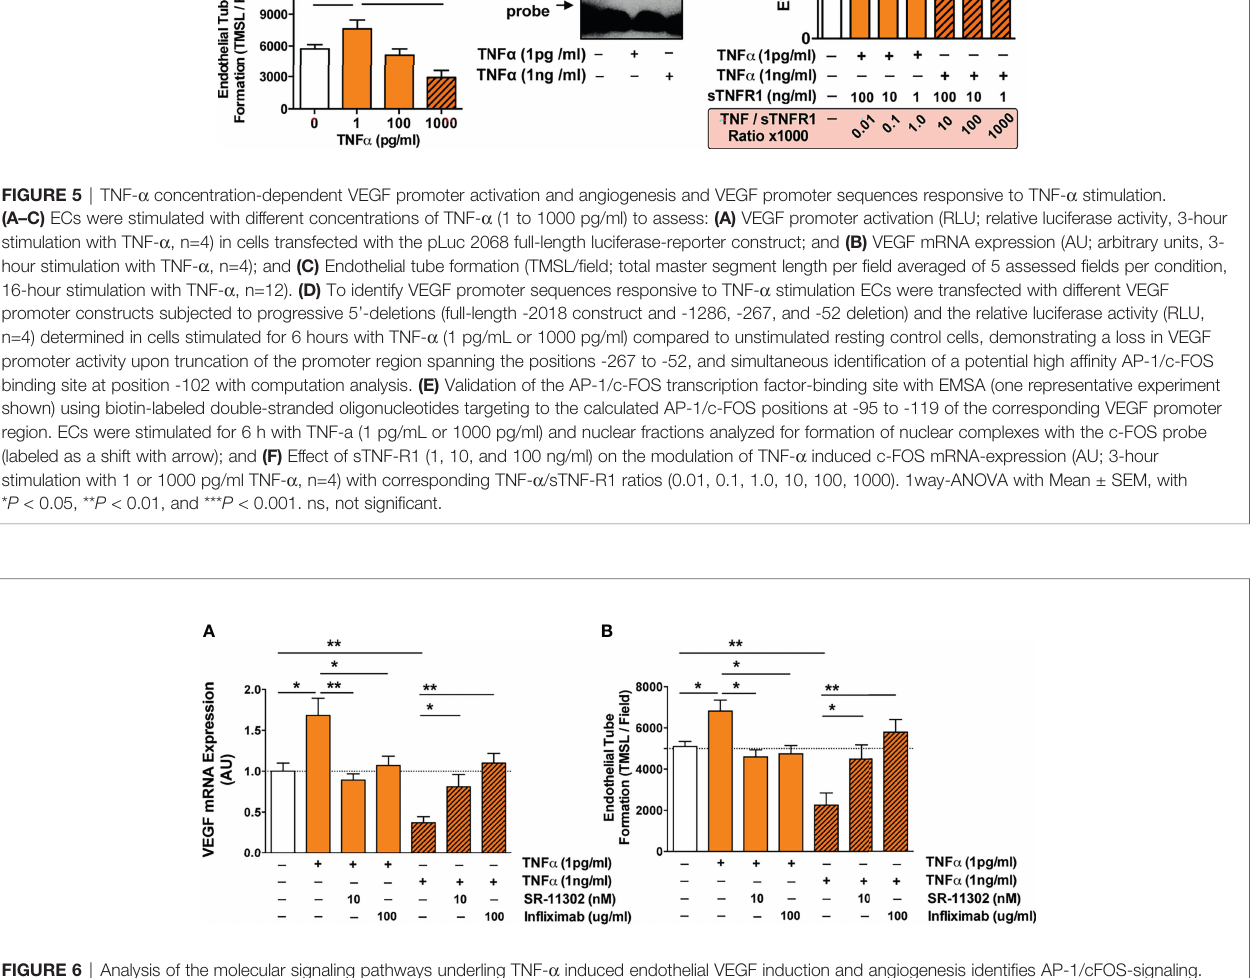
FIGURE 6 | Analysis of the molecular signaling pathways underling TNF- a induced endothelial VEGF induction and angiogenesis identi fi es AP-1/cFOS-signaling. (A, B) Role of the AP-1/c-FOS signaling pathway in low and high TNF- a level-induced endothelial VEGF induction (AU; n=5) shown in (A) and in vitro angiogenesis/ endothelial tube formation (TMSL/ fi eld; total master segment length per fi eld averaged out of 5 assessed fi elds per condition, 16-hour stimulation with TNF- a , n=6) shown in (B) . Cells were fi rst pre-treated with or without AP-1 blocker SR-11302 (10 nM) for 1 hour, followed by stimulation for 16 hours with or without 1 or 1000 pg/ml TNF- a in the presence or absence TNF- a blocking antibody In fl iximab (100 ug/ml). Mann-Whitney-test with mean ± SEM, * P < 0.05 and ** P <